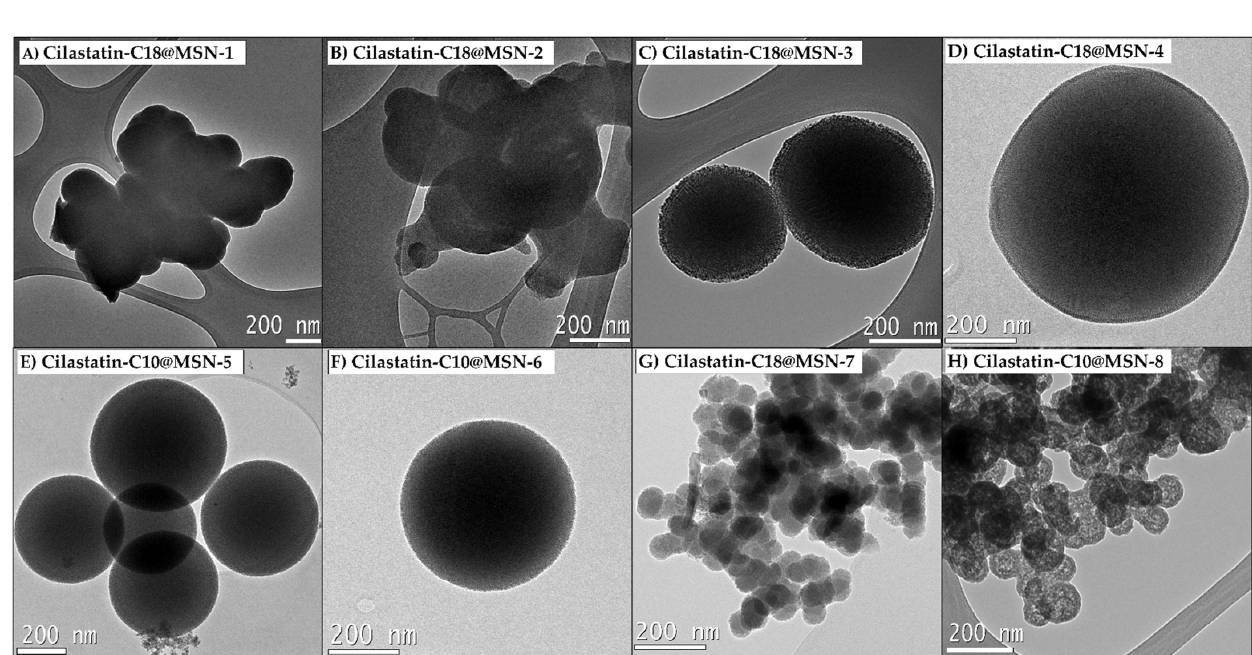
Figure 2. TEM images of the materials synthesized according to the reaction conditions in Table 1. ( A ) Cilastatin-C18@MSN-1; ( B ) Cilastatin-C18@MSN-2; ( C ) Cilastatin-C18@MSN-3; ( D ) Cilastatin-C18@MSN-4; ( E ) Cilastatin-C10@MSN-5; ( F )